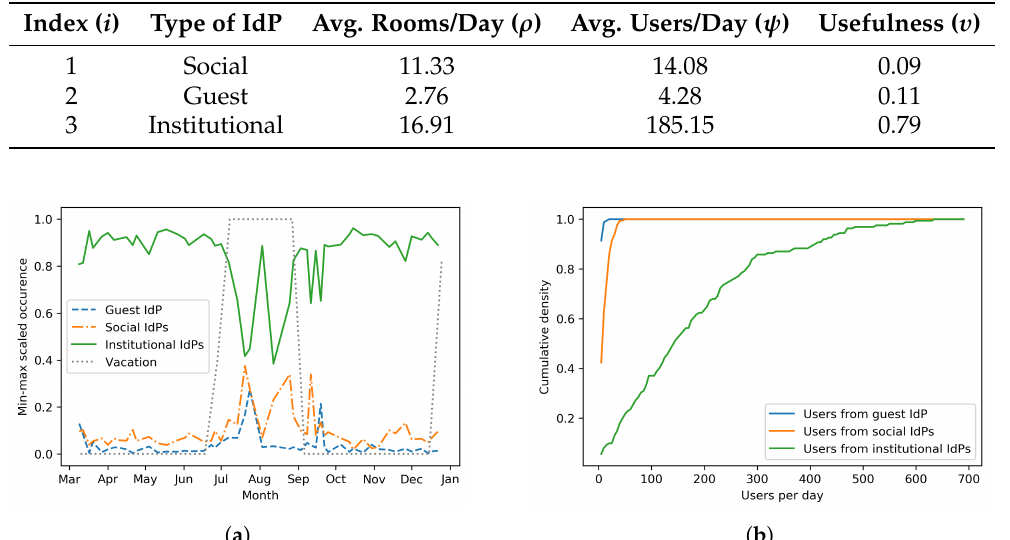
Figure 4. COVID-19 confirmed cases and social distancing level in Korea (2020). ( a ) COVID-19 confirmed cases; ( b ) Social distancing level (min-max scaled). Table 2. Usefulness of each type of identity providers.